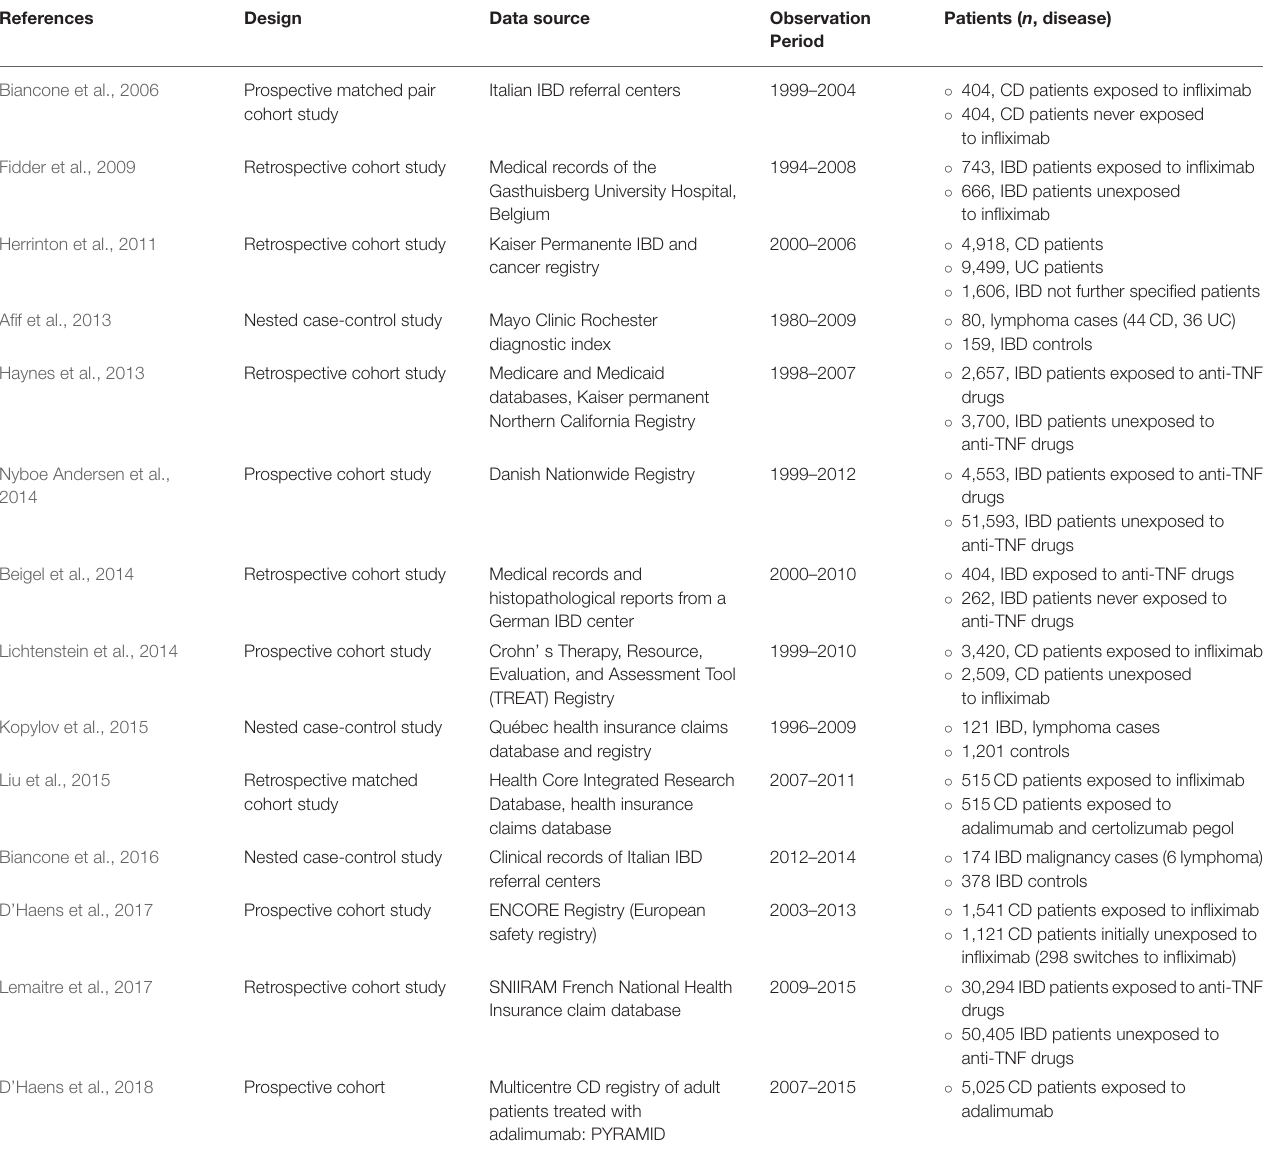
TABLE 1 | Characteristics of the selected